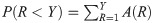
Distribution of the aggregated activity A
i over the rank R
i obtained from the whole reporting period.(inset) Cumulative sum P(R<Y)=∑R=1YA(R). The ceiling of the distribution, which is the capacity of the market over the whole period of time is shown by the grey line, while the orange line shows the corresponding 95% percentile.